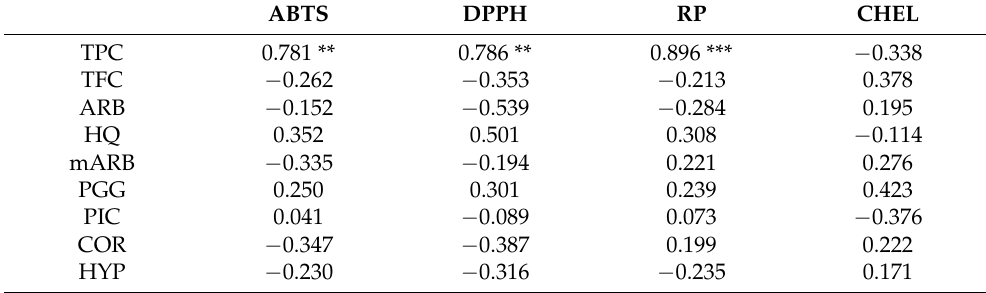
Table 5. Relationships (Pearson correlation coefficients) between the secondary metabolites